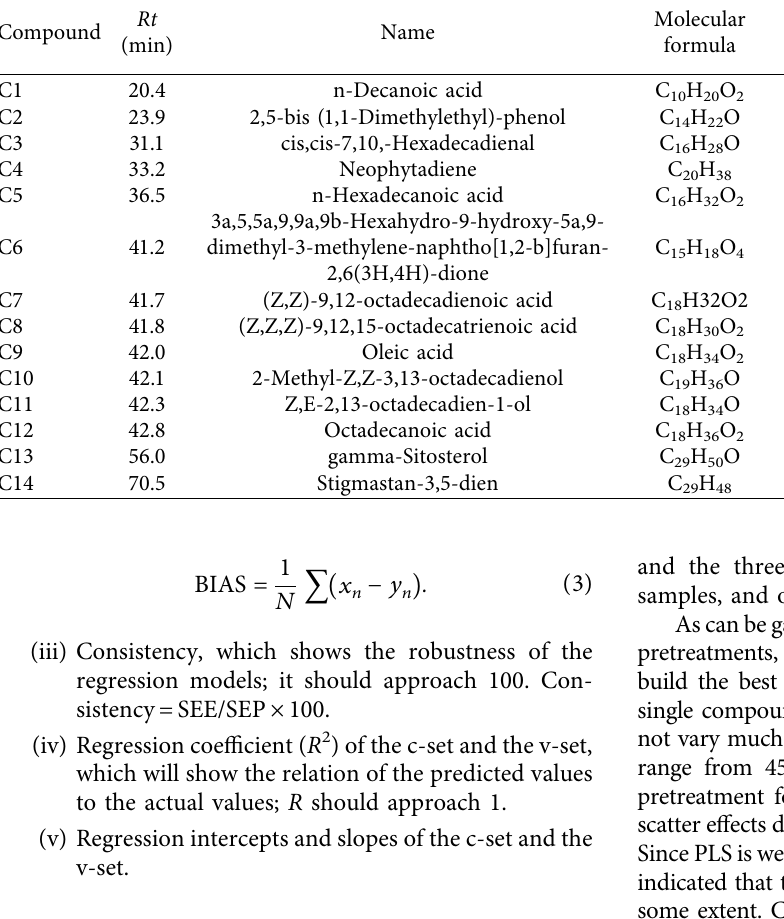
Table 1: 14 selected compounds in A. millefolium which were used for building the NIR regression models.